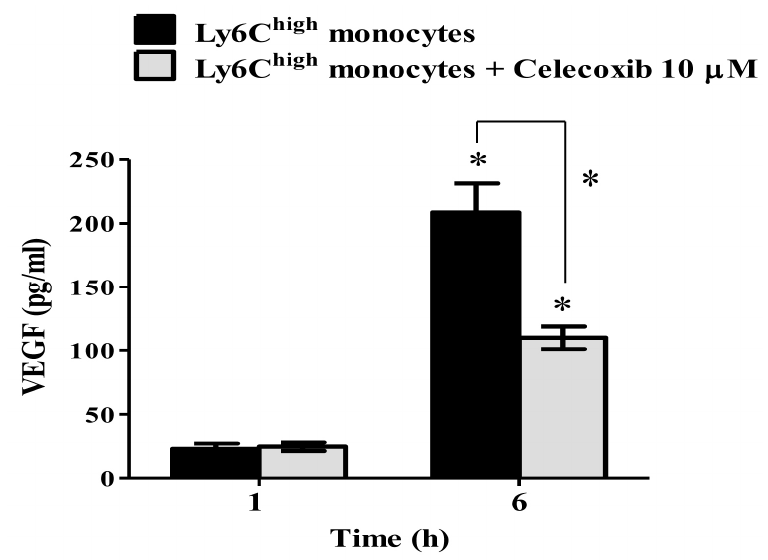
Figure 5. The secretion of VEGF by sorted Ly6C high monocytes was COX-2-dependent. Values represent the mean ± SD ( n = 4). * p < 0.01 compared to individual group of 1 h or compared with group untreated with celecoxib.